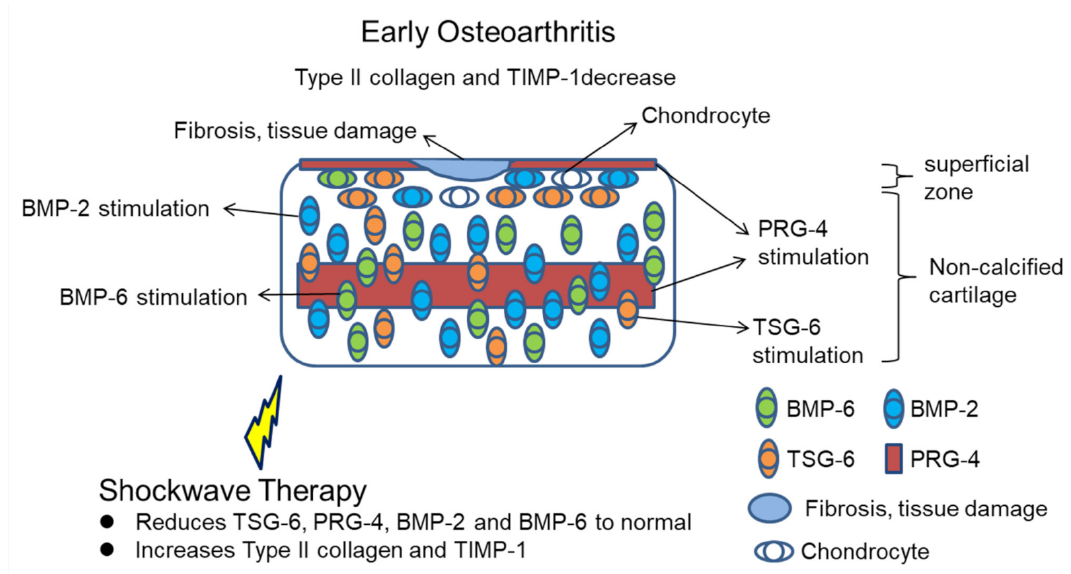
Figure 6. Schematic representation of shockwave therapy modulates the expression of TSG-6, PRG-4, BMP-2, BMP-6, Type II collagen, and TIMP-1 in early